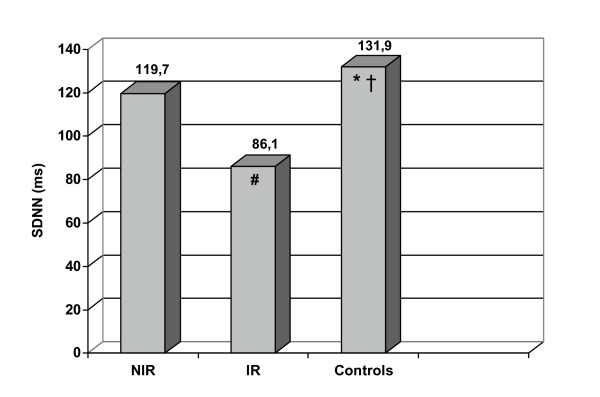
SDNN value in offsprings of type 2 diabetic patients and controls. SDNN: standard deviation of all sinus rhythm RR intervals, IR: insulin resistant offsprings of type 2 diabetic patients, NIR: non insulin resistant offsprings of type 2 diabetic patients. #p:0.003IR vs NIR; *p:0.047 controls vs NIR and † p:0.001 controls vs IR